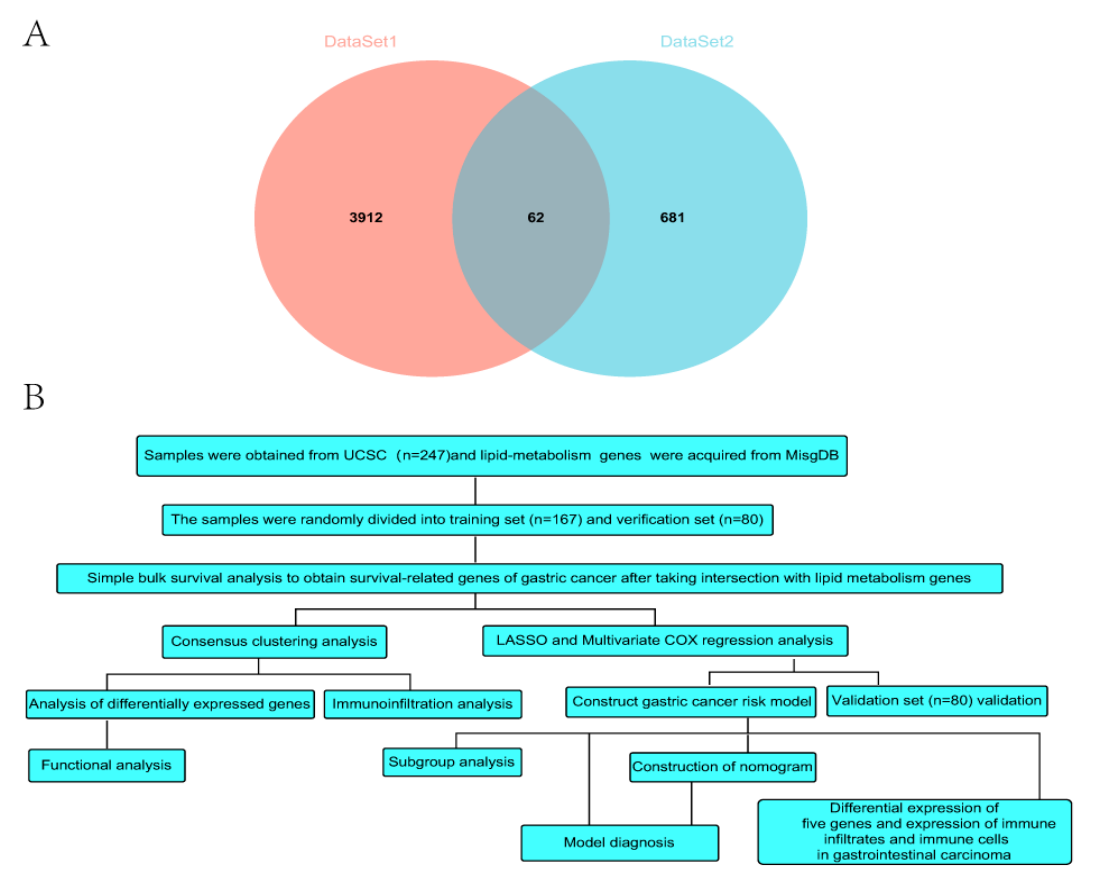
Figure 1. ( A ) Venn diagram of the intersection of survival genes and genes related to lipid metabolism. ( B ) Data analysis flow chart.